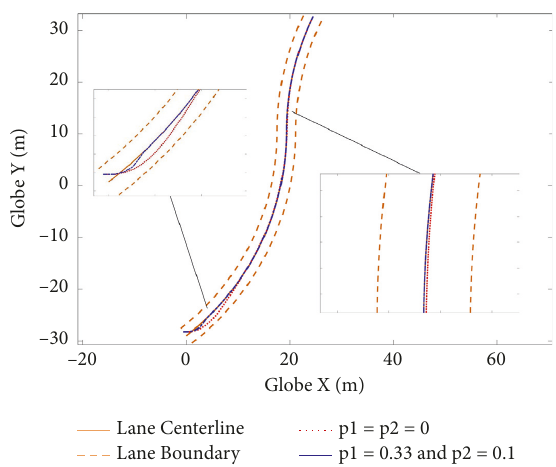
Figure 10: Comparison of different p